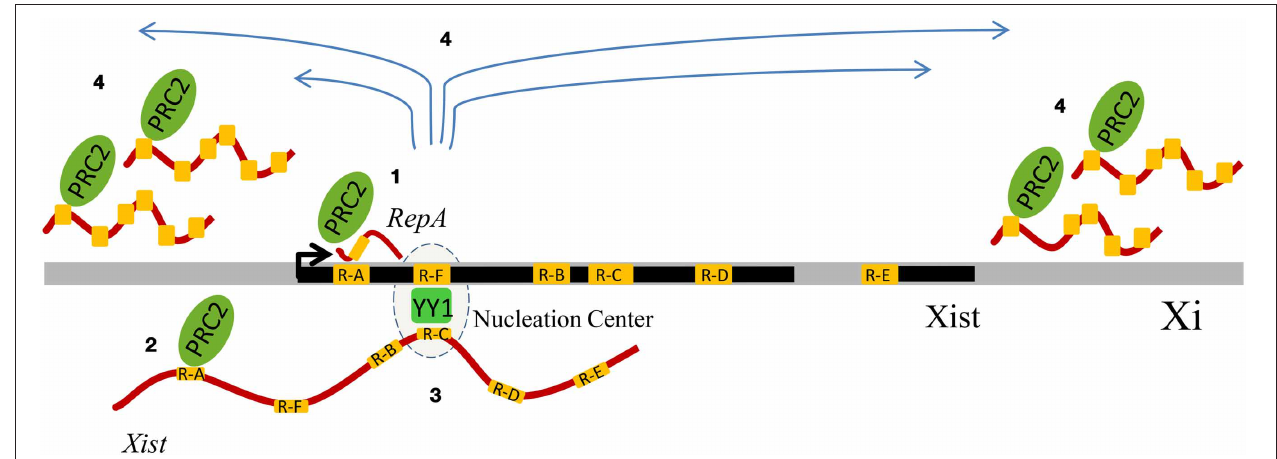
FIGURE 2 | Schematic summary of the influence of genomic repeats on X-chromosome inactivation (XCI). The Xist DNA locus displays tandem repeats (visualized in yellow) and generates multiple transcripts (such as RepA and Xist ), whose contribution to XCI involves binding to Polycomb Repressive Complex 2 (PRC2) and YY1, which has also been associated to Polycomb. Four sequential events of XCI are represented. During the initiation phase of XCI, the Repeat A (R-A) region of the ncRNA